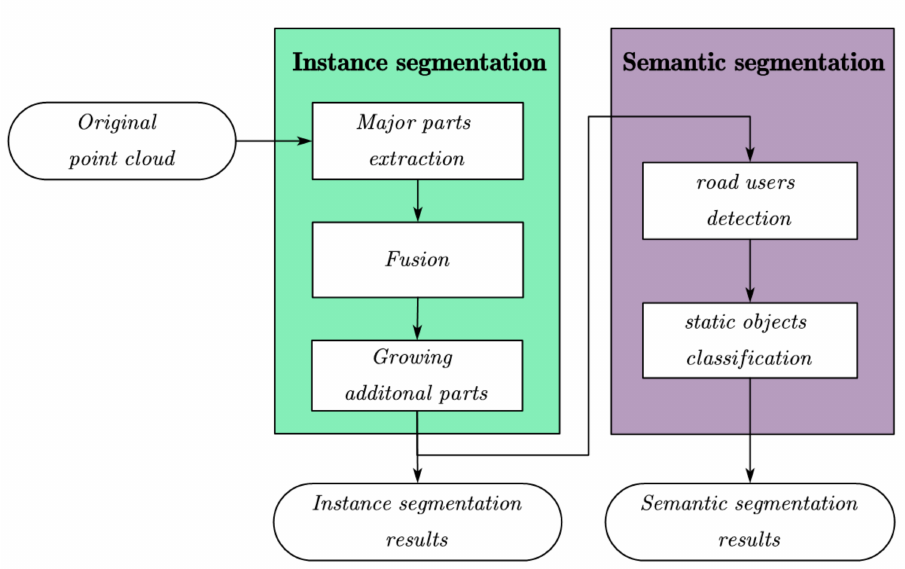
Figure 1. The flowchart of the light detection and ranging (LiDAR) point cloud